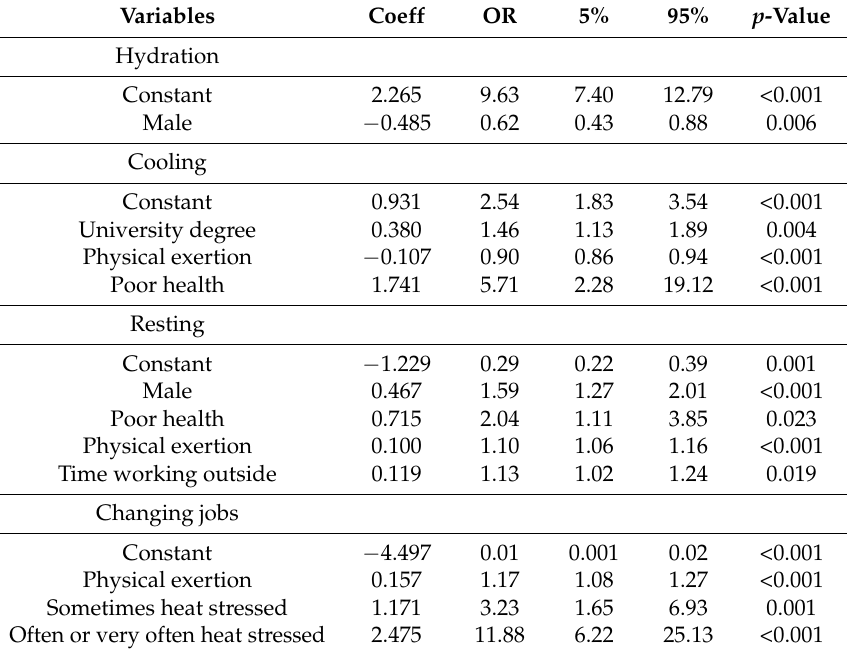
Table 5. Results of separate logit models for each heat stress relief/adaptation measure, model coefficients (Coeff), odds ratio (OR), and 95% confidence interval (lower and upper